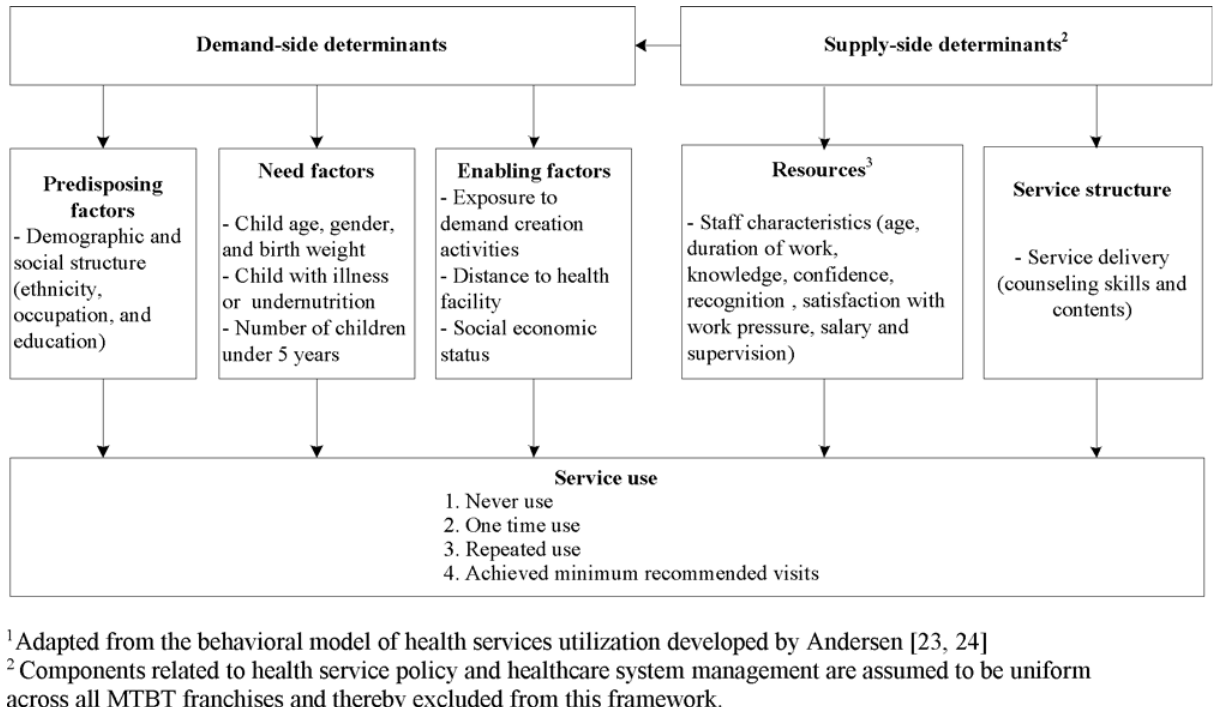
Fig 2. Conceptual framework of determinants of IYCF counseling services utilization. 1 Adapted from the behavioral model of health services utilization developed by Andersen [23, 24] . 2 Components related to health service policy and healthcare system management are assumed to be uniform across all MTBT franchises and thereby excluded from this framework. 3 Infrastructure/facility, equipment, and material resources are assumed to be uniform in all MTBT franchises.